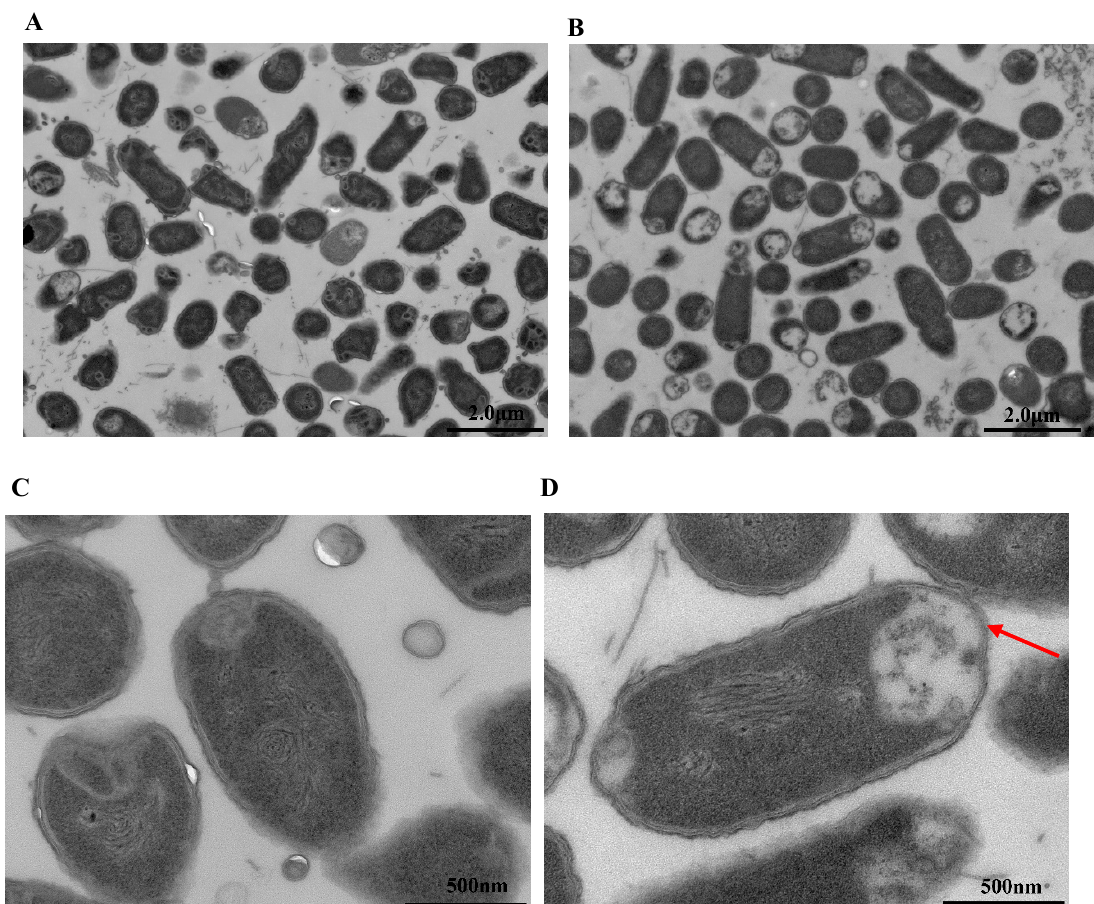
Figure 8. Transmission electron micrograph (TEM) of S . Enteritidis ATCC 13076. ( A , C ) Blank group: The cells were treated with 0.5 mM EDTA for 20 min and amplified by transmission electron microscopy for 0.2 µ m and 500 nm. ( B , D ) Experimental group: The cells were treated with 0.5 mM EDTA for 20 min and 100 nM endolysin LysSE24, amplified by transmission electron microscopy for 0.2 µ m and 500 nm.